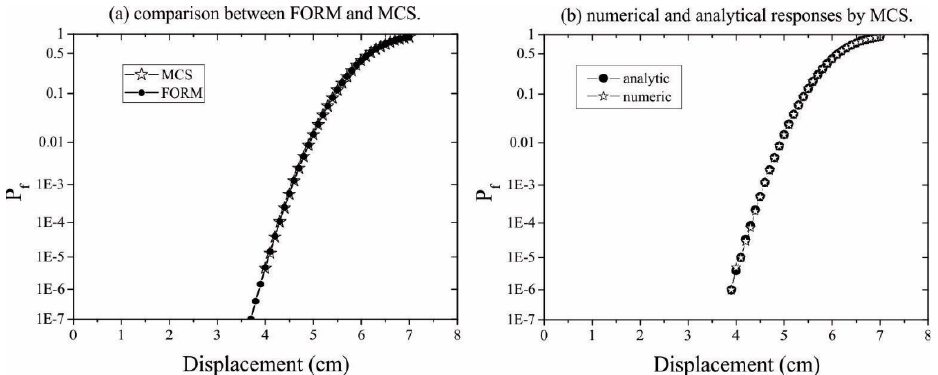
vs . displacement curve. Linear elastic solution for buckling: (a) comparison between FORM and MCS and (b) Figure 7. comparison of numerical and analytical responses by 𝑃𝑃 [ 𝑓𝑓 | 𝛿𝛿 ]